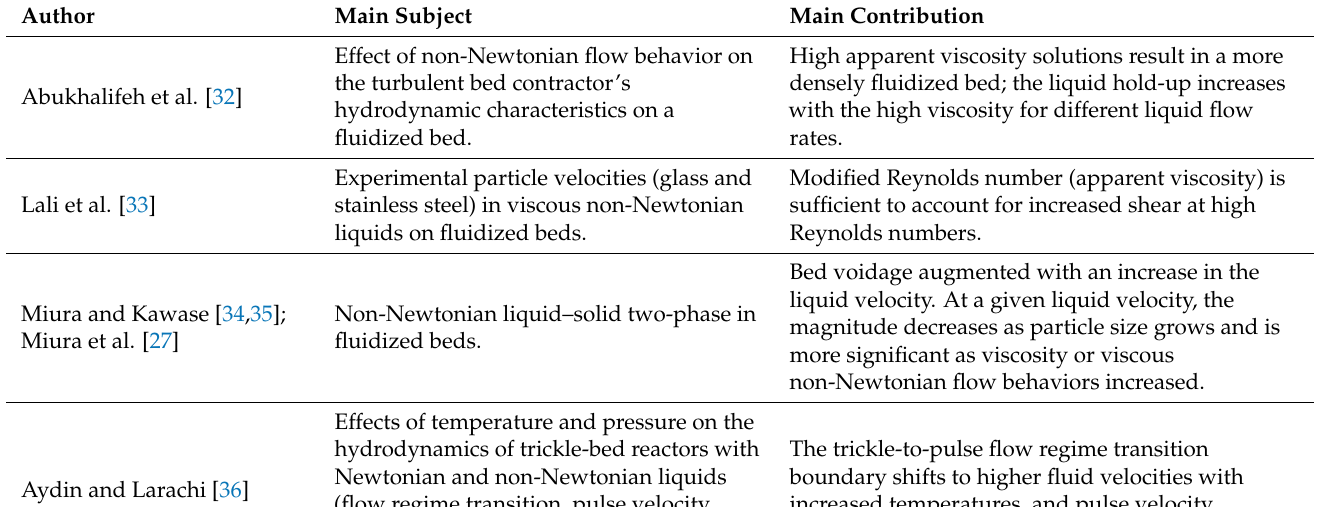
Table 1. Applications of CMC and XG in mixing